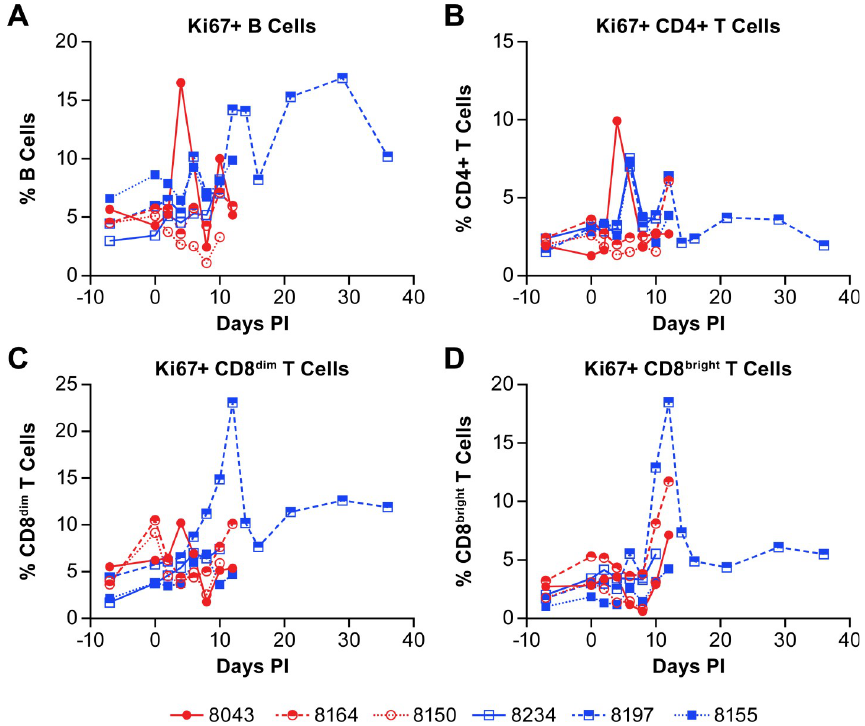
Fig 8. B and T cell proliferation in animals infected with NiV. The percent of proliferating (Ki67+) (A) B cells, (B) CD4+ T cells, (C) CD8 dim T cells and (D) CD8 bright T cells are shown as the total population of the analyzed cells from individual animals. Red circles indicate the low dose group and blue squares indicate the high dose